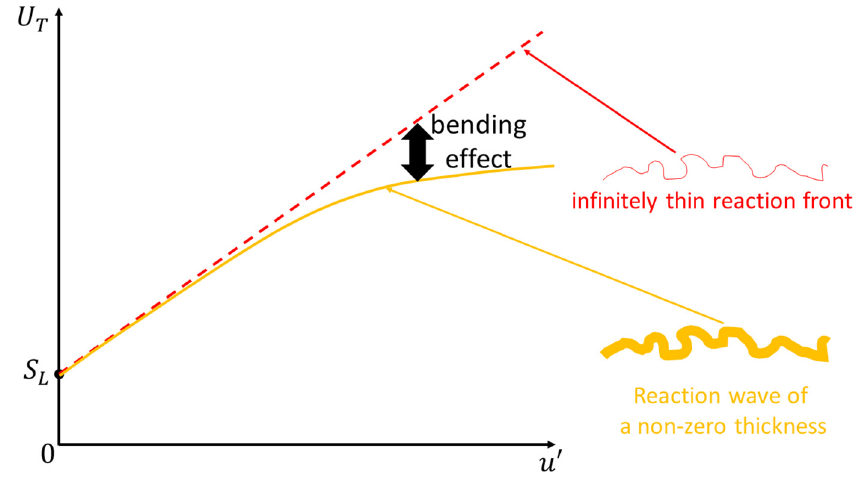
Figure 1. A sketch of the bending effect for turbulent consumption velocity U T as a function of the rms turbulent velocity u’.